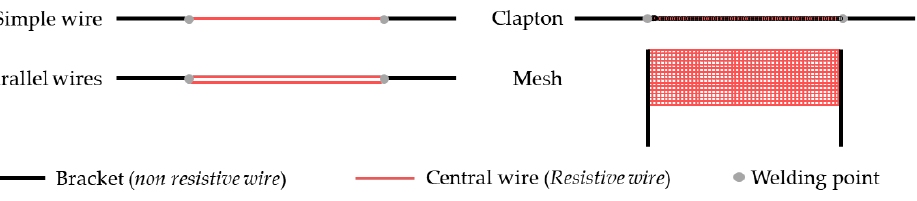
Figure 6. Scheme of the four heating elements designs extracted in the twenty-six tested devices. Through the twenty-six electronic cigarettes tested, four types of set-up are observed. Each of them has brackets (non-resistive) that makes the electric connections with the power unit. Then, a central resistive part is welded to the brackets. The four types of set-up could be distinguished by their central part. They could be a simple wire or two parallel ones (GS Air, Prism T18, Cosmo, Melo III and TFV8) that are bare wires. Others have a central simple or parallel wire(s) that has a non-resistive wire rolled around, commonly named Clapton set-up (Cleito). Finally, the central part could be a mesh composed of the thinnest wires than the others set-up (Iqos Mesh, Zeus, Sub-Leto24, Fat Rabbit and Fireluke 2). An analysis of these manufacturer data is provided in the results sections. As